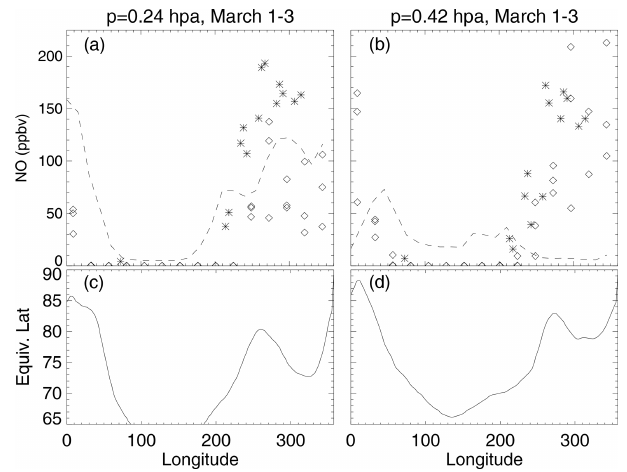
NO data (stars), and SOFIE NO data (diamonds) vs. longitude. The WACCMX NO output is for 2 March, and the two datasets cover the period 1–3 March. As in Fig. 8, the geographic latitude is 81 ◦ N. Bottom panels show the calculated equivalent latitudes vs. longitude for this geographic